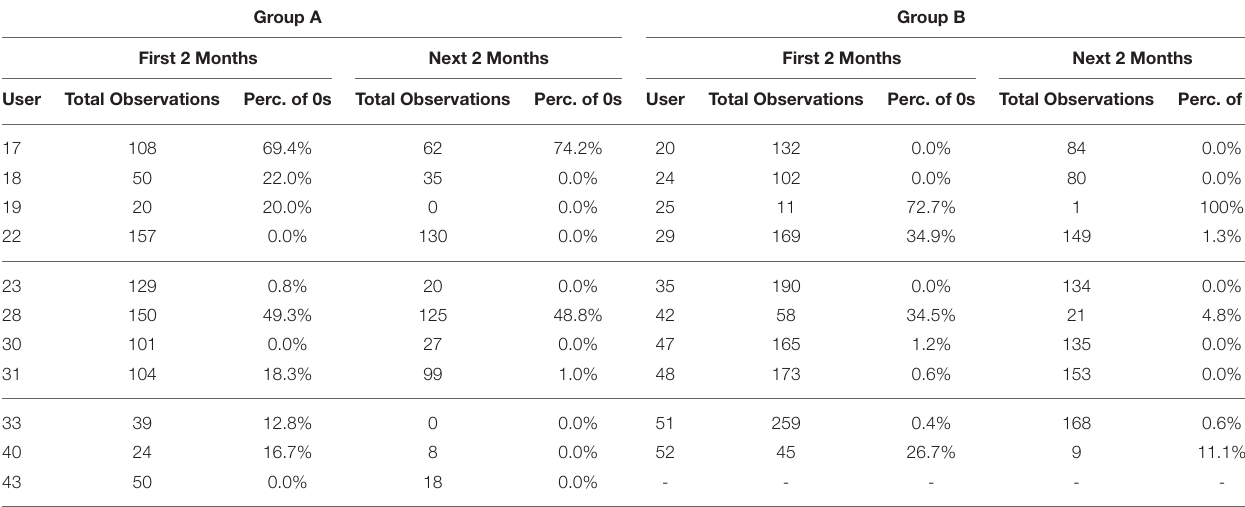
TABLE 2 | Number of times users answer zero for S01 in relation to their total number of observations overall in their first 2 months and next 2 months of the study for group A and group